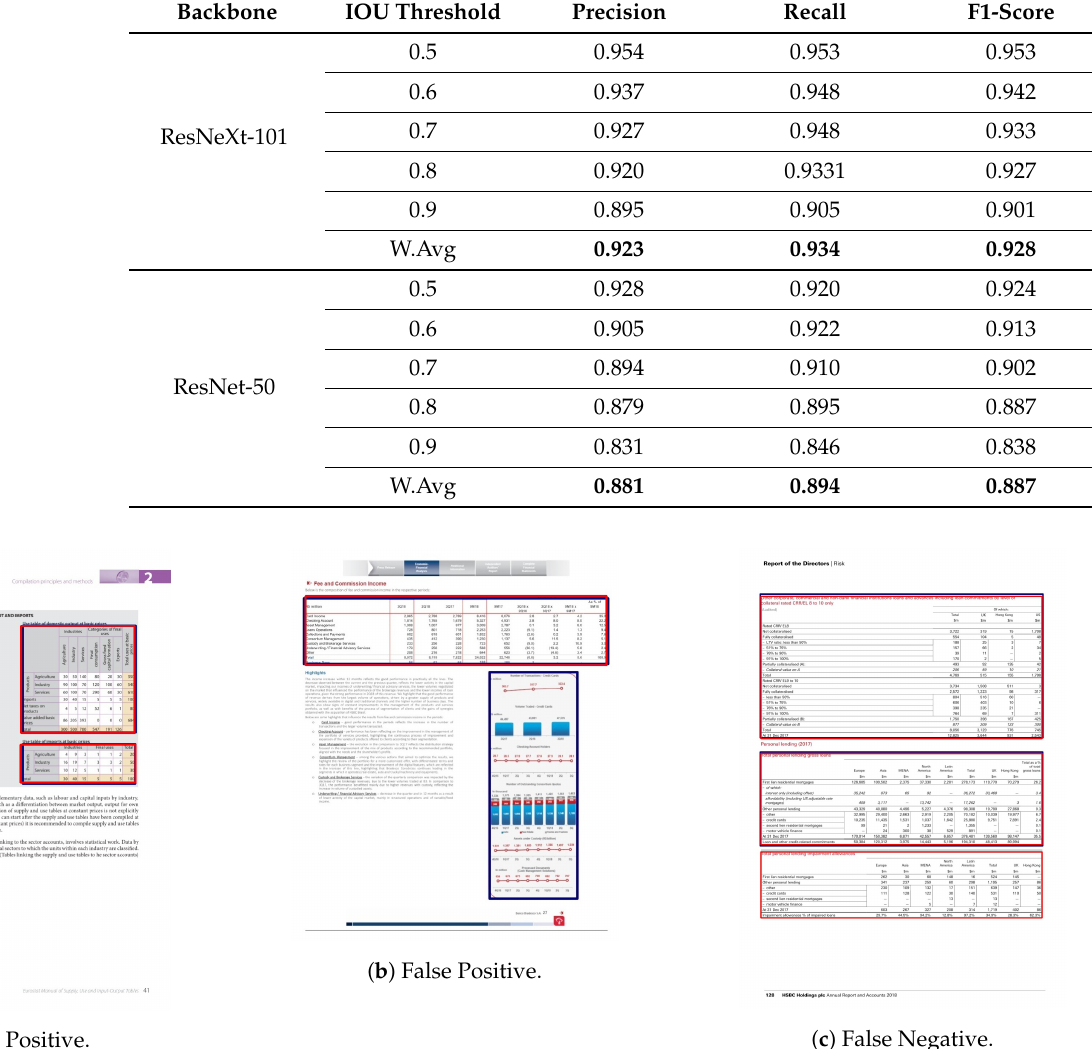
Table 1. HybridTabNet results on the ICDAR-19 dataset with deformable ResNeXt-101 and ResNet-50 backbones. W.Avg denotes the weighted-average of the respective measure on the IoU threshold.